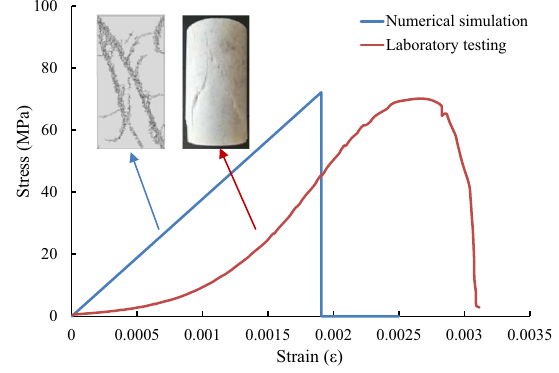
Fig. 1 Typical stress–strain curves and failure modes of marble speci- men under uniaxial compressive test based on numerical simulation and laboratory testing